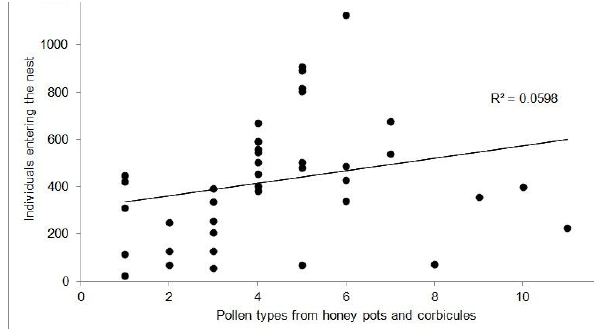
Fig 4. Relationship between the number of pollen grain types (from corbiculae loads and honey from pots) with the total numbers of pollen and nectar foragers returning to the Table 2. Pollen types present on the corbiculae of the workers (*) and honey pots (+) in 5 Melipona quadrifasciata nests, sampled during 9 months (December 2009 to September 2010) in the Parque das Neblinas.